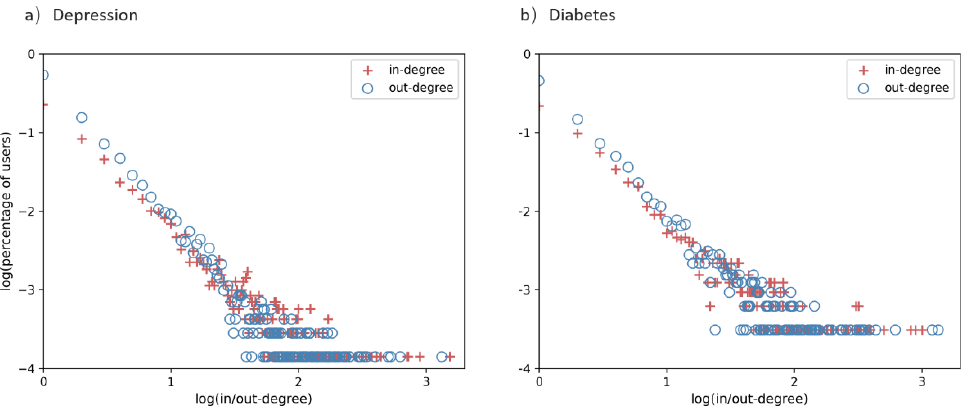
Figure 8. Distribution of users ’ in/out-degree for the aggregated networks in online ( a ) depression and ( b ) diabetes communities.